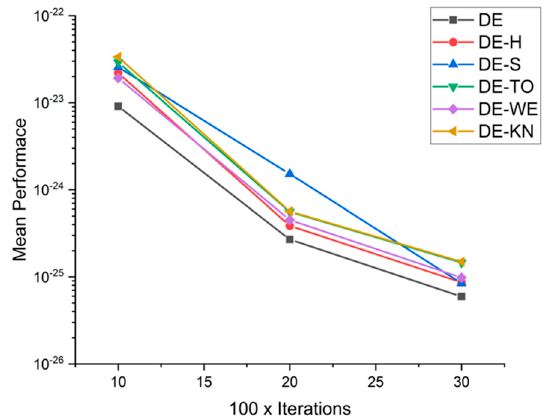
Figure 35. Convergence curve on fn13.